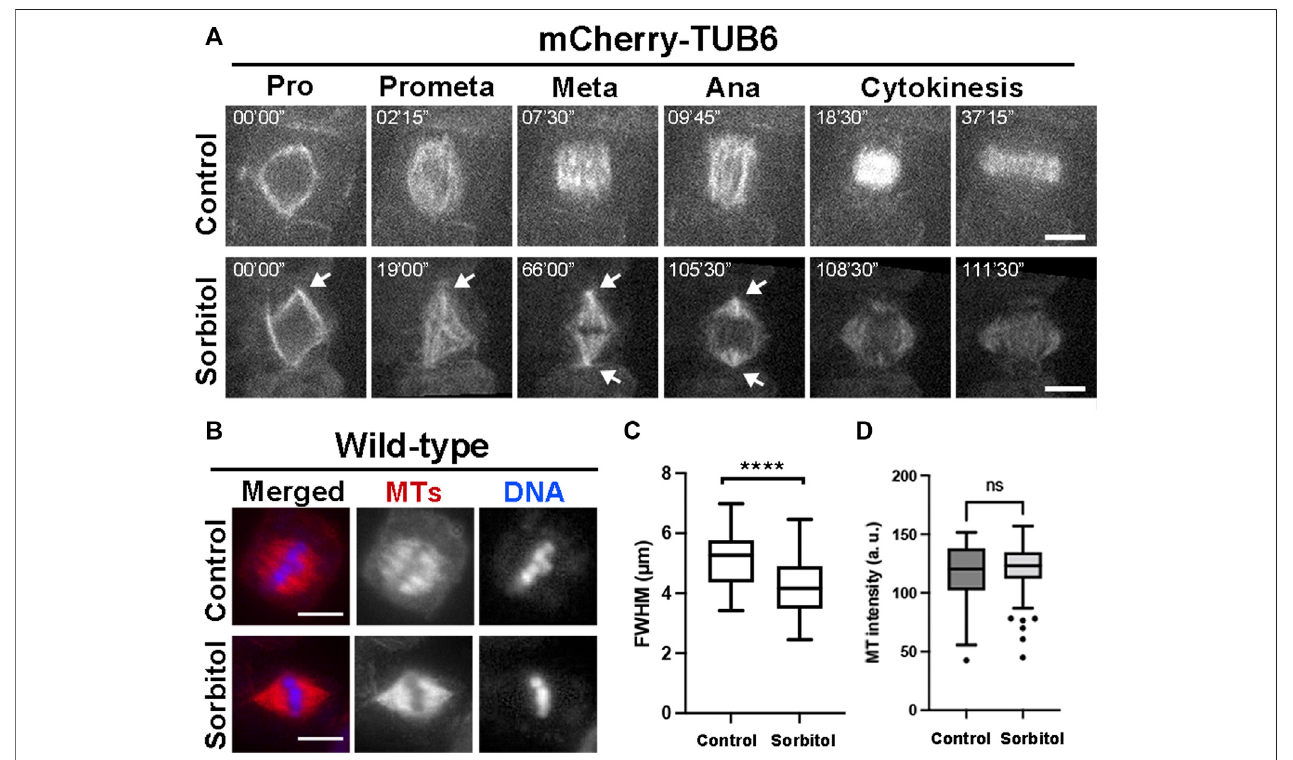
FIGURE 3 | Induction of highly converged spindle poles under hyperosmotic conditions in A . thaliana . (A) Mitotic MT arrays were reported by a mCherry-TUB6 fusion protein. Without 0.3 M sorbitol treatment (control), a mitotic cell organizes MTs to prophase (Pro) spindle on the nuclear envelope. Following nuclear envelope breakdown,themitoticspindle hasMTsorganized withwidespindlepolesatbothmetaphase (Meta)and anaphase(Ana).Withthesorbitolchallenge, spindleMTarrays remainsharplyfocusedwithsharppoles(arrows)andMTscontinuouslyreorganizeintothephragmoplastarray. (B) SpindleMTarraysinwild-typecellsexposedto water(control) or treated with 0.3 M sorbitol, followed byanti-tubulinimmuno fl uorescence. After sorbitol treatment, the spindle MTarray with widepolesin thecontrolis replaced by a spindle with sharply focused poles. (C) Quantitative assessment of spindle pole convergence by measuring the full width at the half maximum (FWHM) values of the spindles under the two conditions with statistical signi fi cance indicated. The FWHM values drop signi fi cantly after sorbitol treatment. (D) Quantitative assessmentofMTdensityinmetaphasespindles,followingsorbitoltreatmentwhencomparedtountreatedcells(control).Nosigni fi cant(ns)differencewasfound.Scale bars, 5